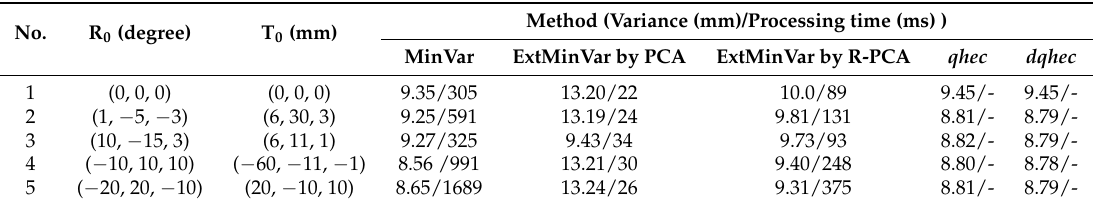
Table 1. Results of robot head-eye